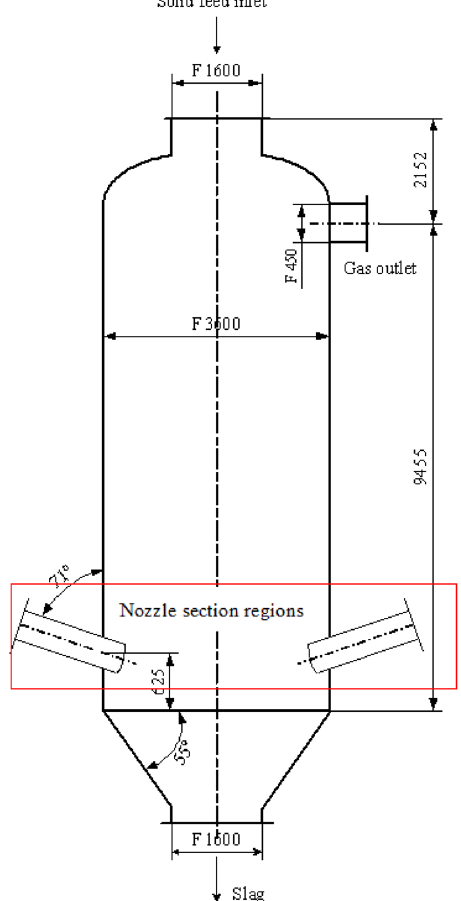
Fig. 1 Gasifier geometry